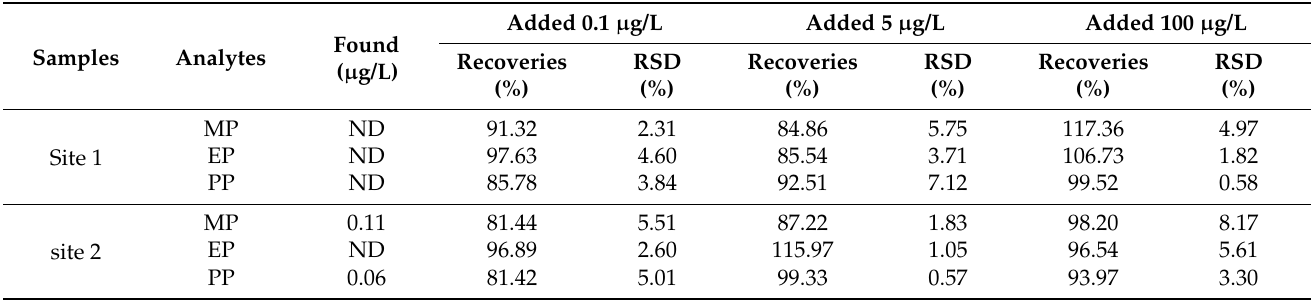
Table 5. Detection of parabens in environmental water samples and analysis of recovery (n =